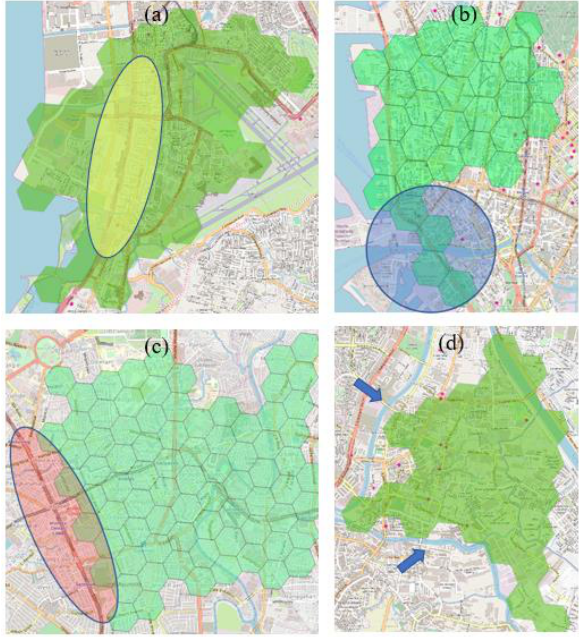
Figure 12. Common characteristics of clusters and its dependence on roads and water bodies are shown. Encircled are roads that relay important dependence on the clusters such as (a) Roxas boulevard (yellow) that acts as skeleton, (b) Radial road 10 (blue) that act as gates going to and from the cluster, and (c) East avenue (red) that acts as boundary of the cluster. Water bodies also act as boundaries such as (d) Marikina River and Pasig river that shaped the cluster as shown by blue